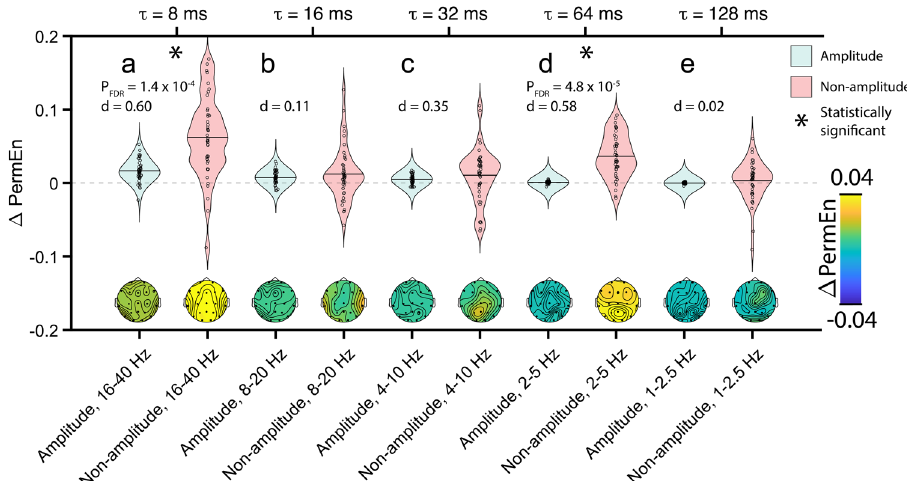
Fig. 7 Permutation Entropy (PermEn) decomposition. Violin plots (top row) display Δ PermEn in AS between wakefulness and NREM sleep driven by amplitude (blue-gray) and non-ampltidue amplitude (pink) effects for a PermEn8, b PermEn16, c PermEn32, d PermEn64, and e PermEn128. Positive values of Δ PermEn indicate greater PermEn during wakefulness. Solid black horizontal lines inside violin plots represent the mean of each distribution, and statistically signi fi cant comparisons of amplitude and non-amplitude contributions are marked with asterisks. Topographic scalp plots (bottom row) show the spatial distribution of Δ PermEn averaged across all participants with AS. Source data are presented in Supplementary Data